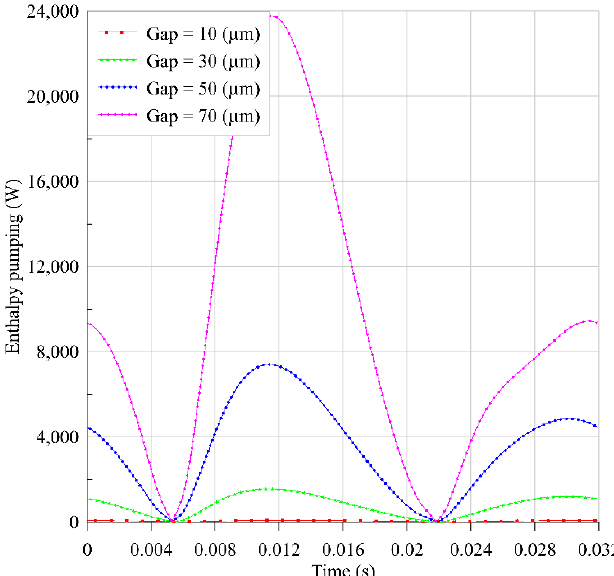
Figure 12. Decoupled enthalpy pumping at different gap sizes with T f .